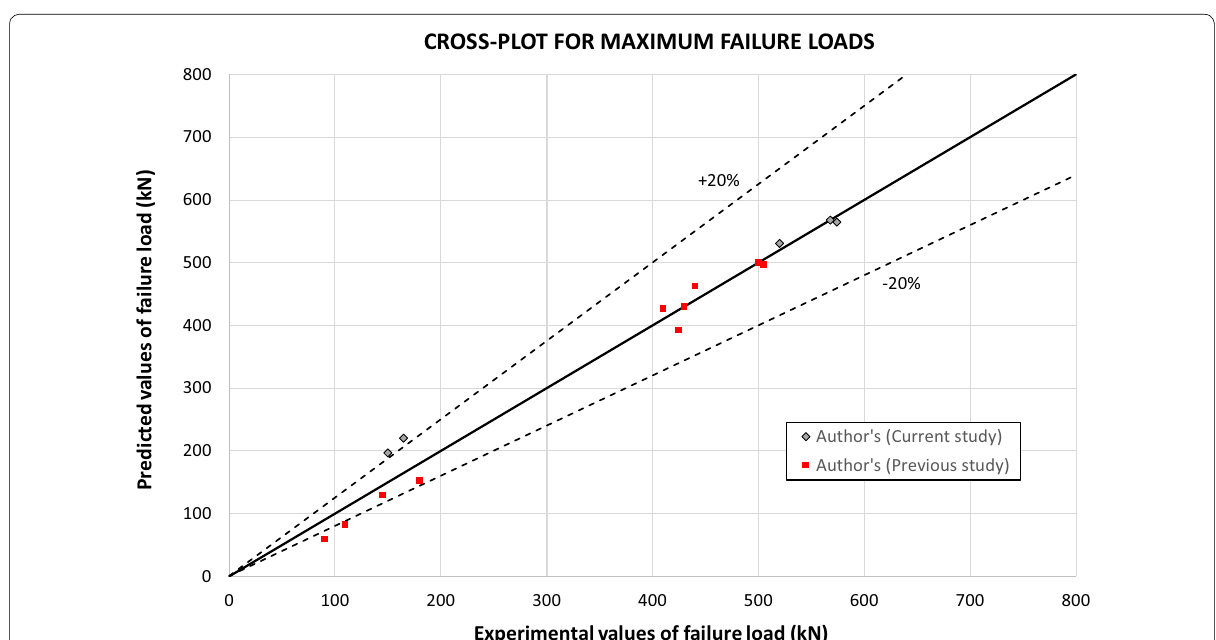
Fig. 14 Cross-plot of experimental values of ultimate failure load versus analytical values found from the regression Eq. (2) for specimens of the current research and specimens found in the bibliography.